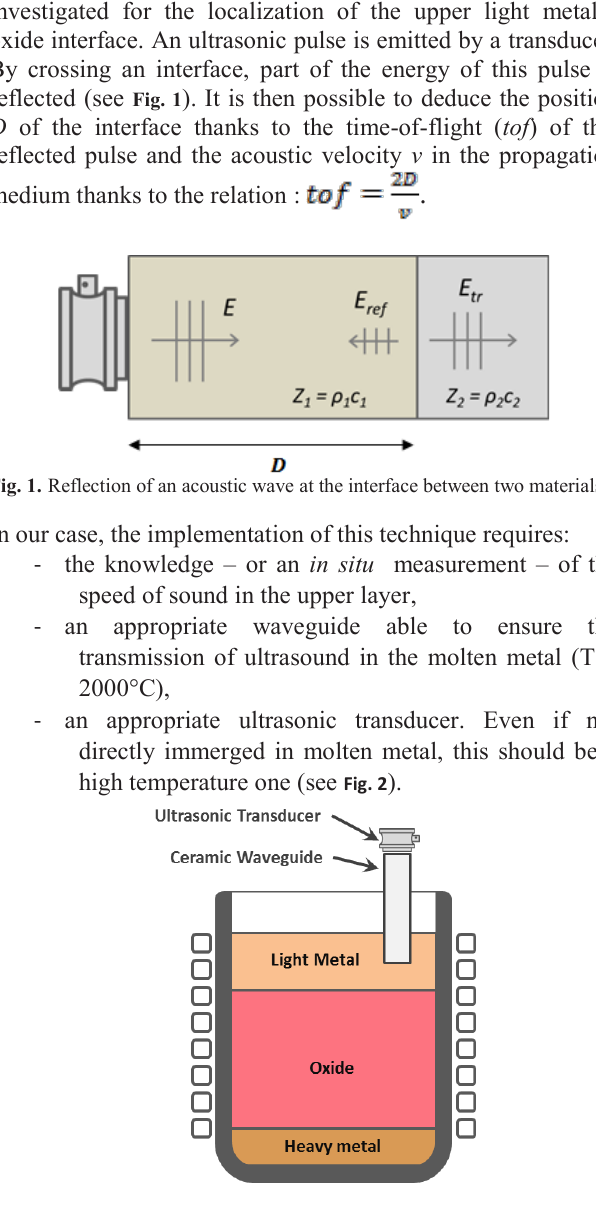
Fig. 2. Principle diagram of acoustic measurement with a ceramic waveguide.